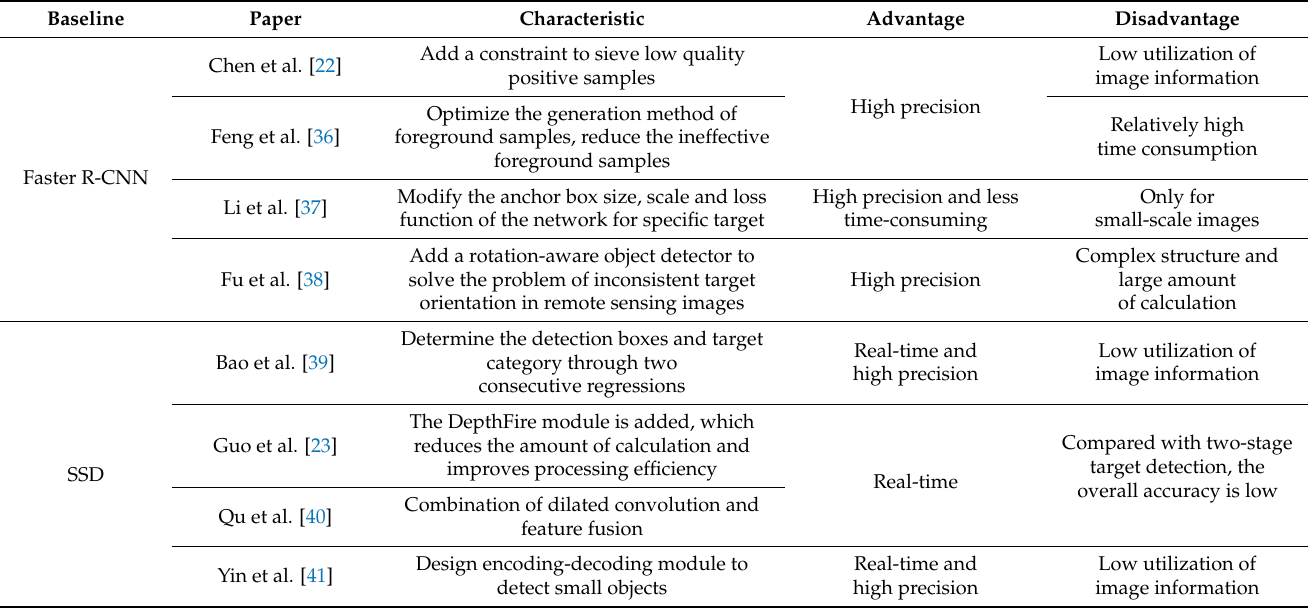
Table 1. Related works on the improvement of mature target detection